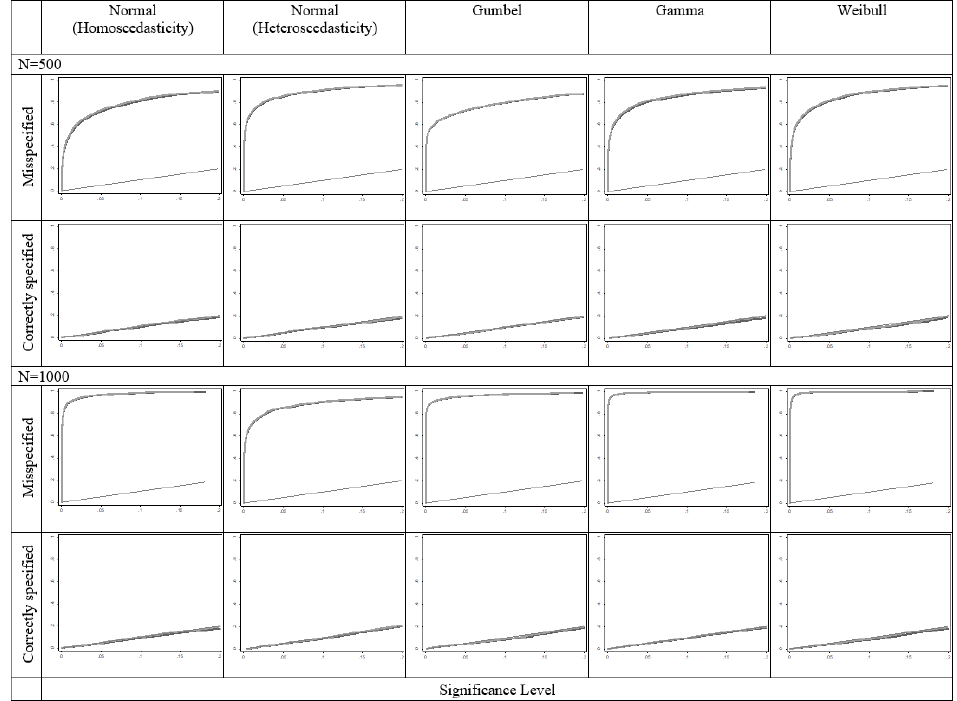
Table 4. Monte Carlo Simulation: Empirical CDFs of Experiments on Parameter